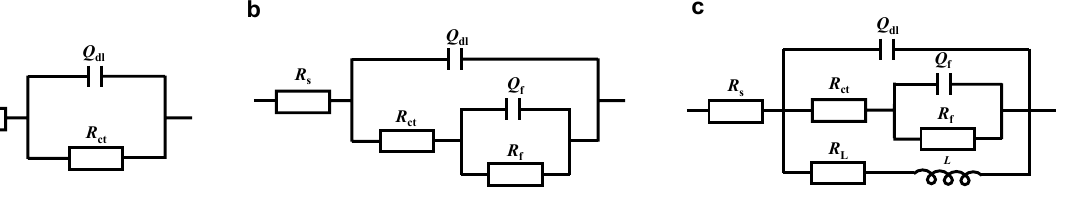
Figure 5. Fitting circuit of EIS results in Figure 4. Note: ( a ): 20% HCL, pH = 1, and pH = 3; ( b ): 20% HCL + Mb and pH = 3 + Mb; ( c ): pH = 1 + Mb. Table 2. Fitting parameters of EIS of casing steel immersed in fresh and residual acid solution with or without Mb inhibitor for 4 h.